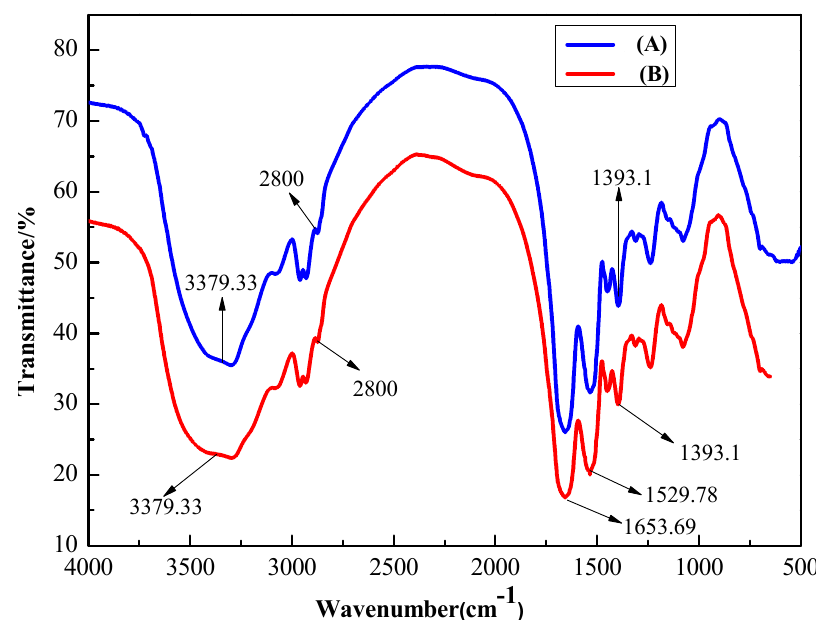
Figure 9. The infrared spectra of SPI before and after the SDS modification.